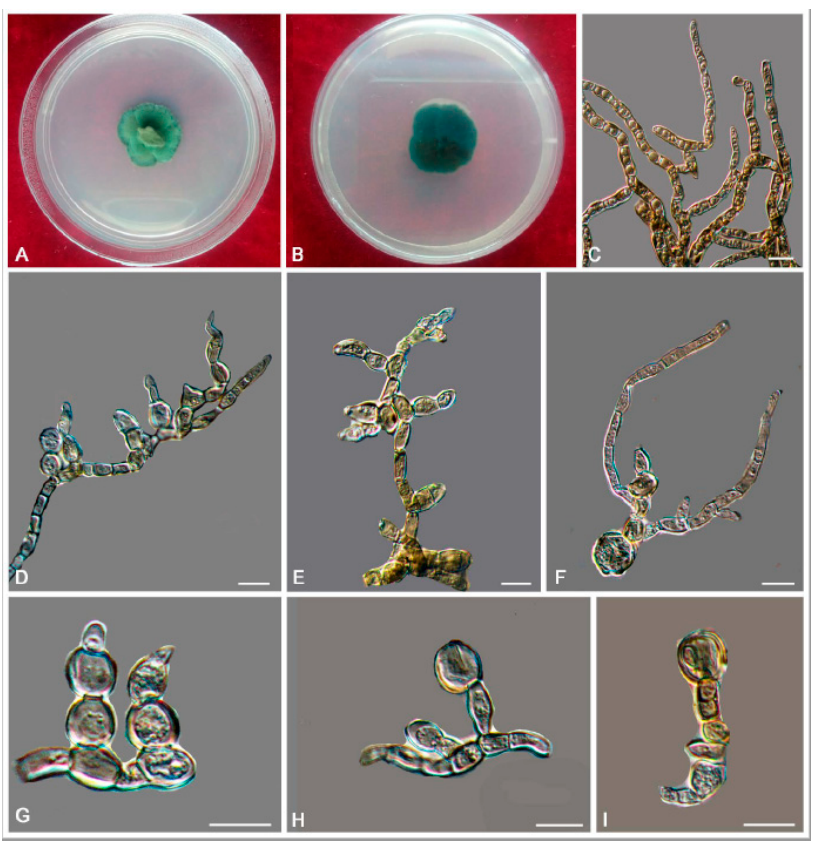
Figure 16. Trichomerium leigongense (CGMCC 3.17983). ( A , B ) Colony forward and reverse after 20